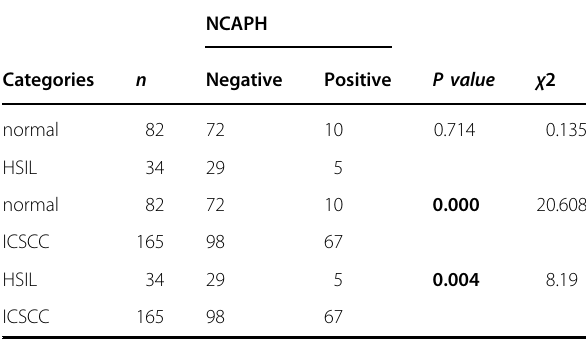
Table 1 Expression of NCAPH in cervical tissue